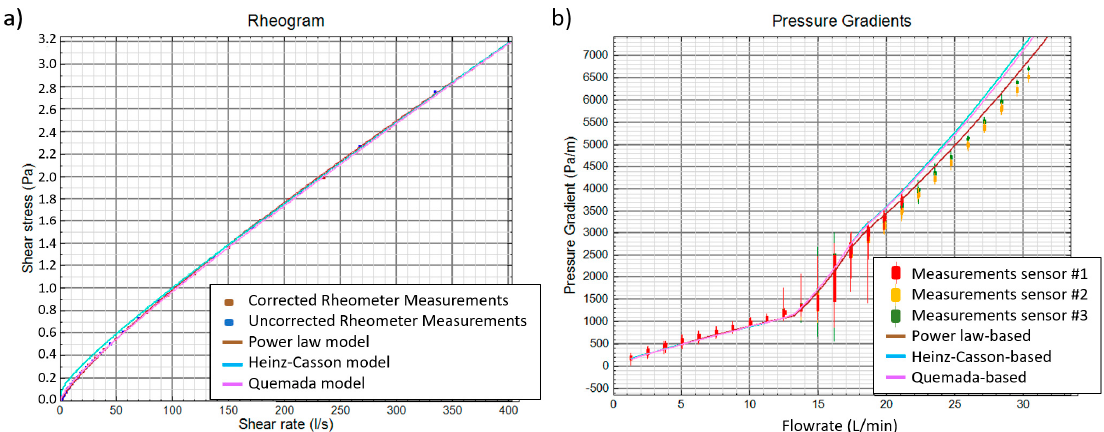
Figure 10. ( a ) Rheogram of an aqueous solution of Carbopol with low molecular weight (0.07%) measured at 25 °C with a scientific rheometer, ( b ) comparison between measured pressure gradients with the three differential pressure sensors and pressure gradients calculated with power law, Quemada and Heinz–Casson rheological behaviors.